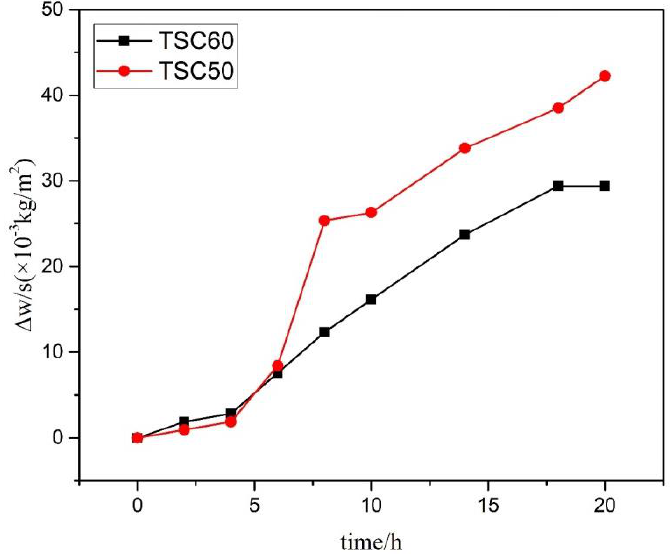
Figure 7. Weight gain per unit area of TSC50 and TSC60 at 1400 °C for 20 h. As discussed, pores and cracks were present on the oxidized surface of Ti 3 SiC 2 /Al 2 O 3 , providing a diffusion channel for oxygen. Therefore, the oxidation of Ti 3 SiC 2 /Al 2 O 3 was a diffusion-controlled process. Moreover, the oxidation of Ti 3 SiC 2 was caused by the outward diffusion of Ti, Si and carbon, and the inward diffusion of oxygen. Although the oxidation of Ti 3 SiC 2 /Al 2 O 3 was a diffusion-controlled process, the addition of Al 2 O 3 changed the composition of the oxide layer. The cross-section of the oxide layer after 20 h of oxidation is shown in Figure 8. The thickness of the oxide layer of TSC60 was approximately 253 µ